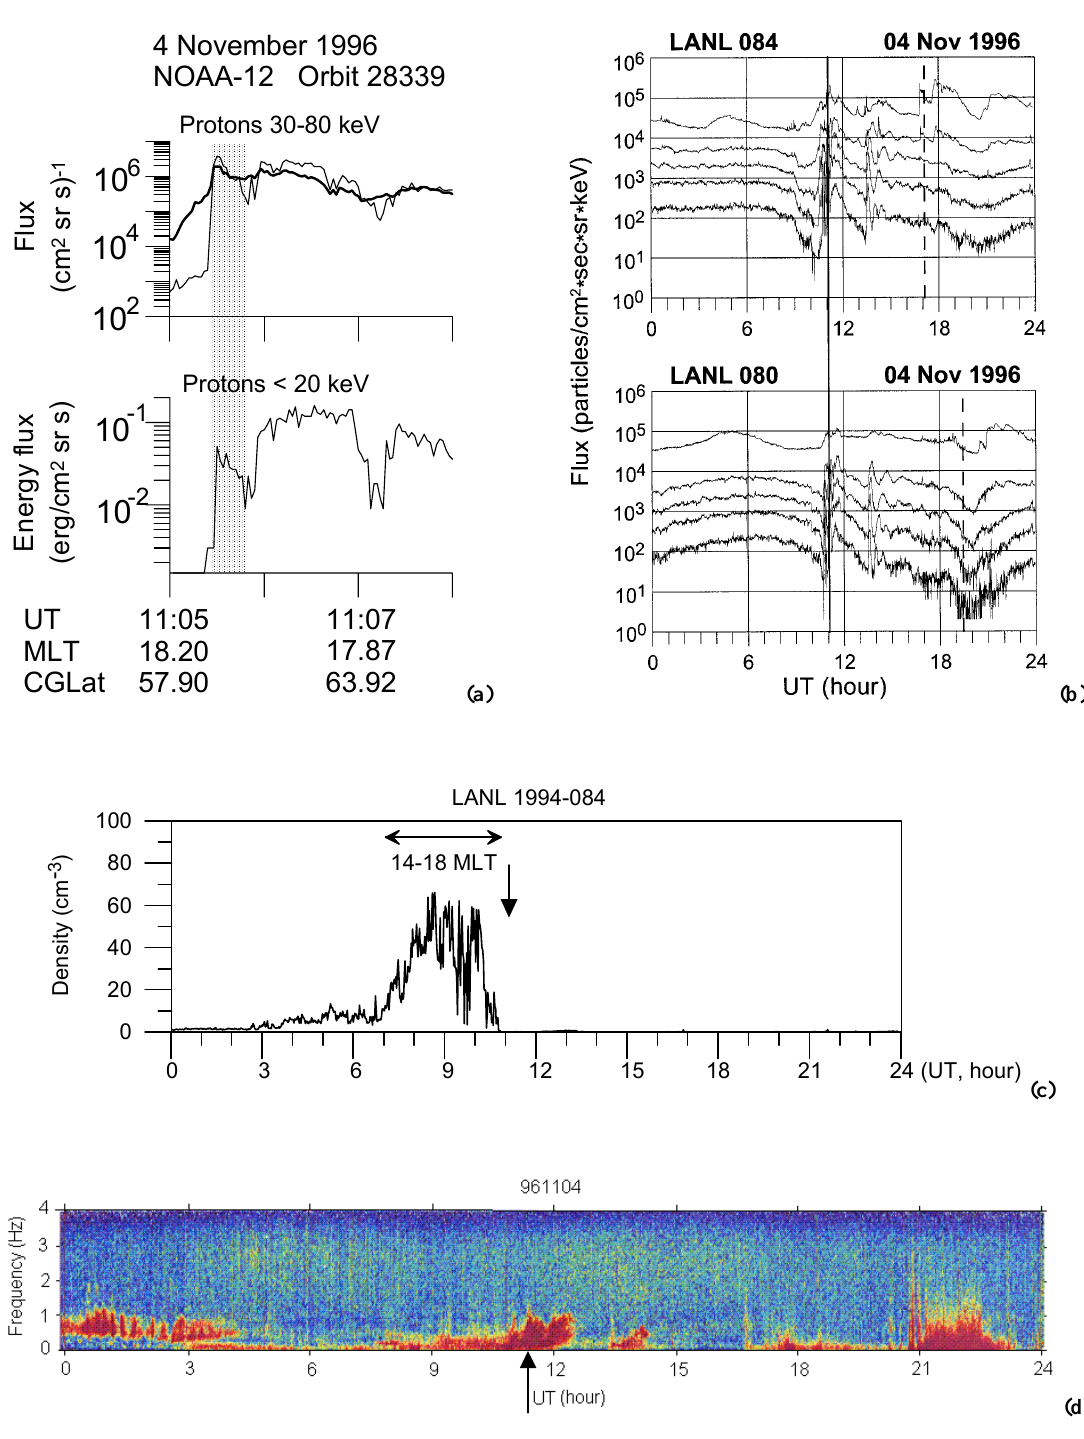
Fig. 5. The Type 2 event associated phenomena. (a) The NOAA-12 data showing the Type 2 event at 11:05:30UT on 04 November 1996. (b) The SOPA instrument data showing the energetic proton fluxes on board the LANL spacecraft. The substorm injection is seen around 11:00UT. Solid vertical line marks the time of the Type 2 event registration. On each panel a dashed vertical bar is plotted at the time for which the satellite was at local midnight. (c) The LANL MPA instrument data showing the cold plasmaspheric plasma increase in the 14–18 MLT range. (d) The daily spectrogram from SGO showing the dynamic spectra of geomagnetic variation in the range of 0.1–4Hz. Arrow marks the time of the NOAA-12 pass. The spectrogram shows the IPDP pulsations around the time of the NOAA-12 observation of the localized proton flux